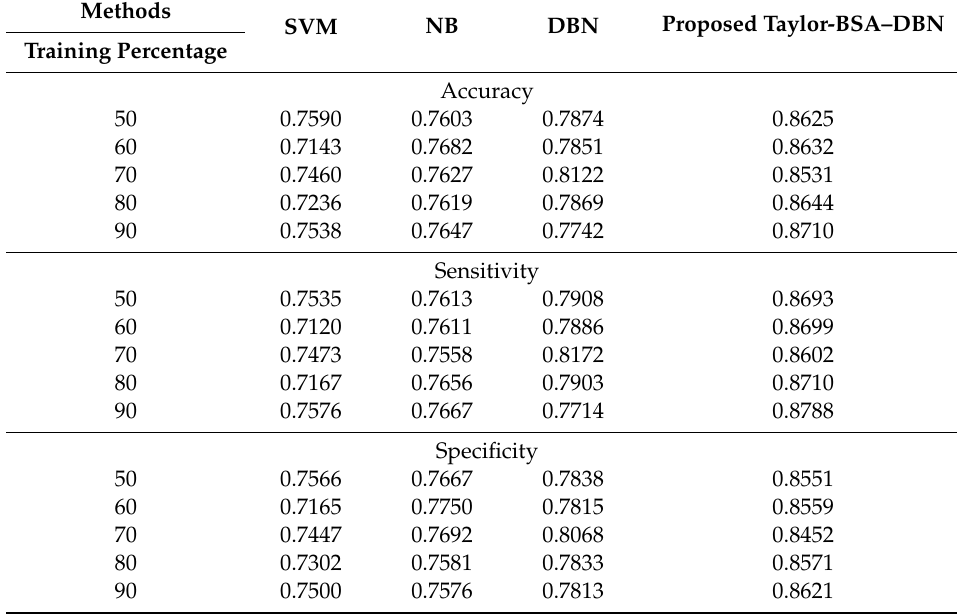
Table 2. Analysis of methods with cluster size = 5 using the Cleveland database. Abbreviations: SVM, Support Vector Machine; NB, Naive Bayes; DBN, deep belief network.